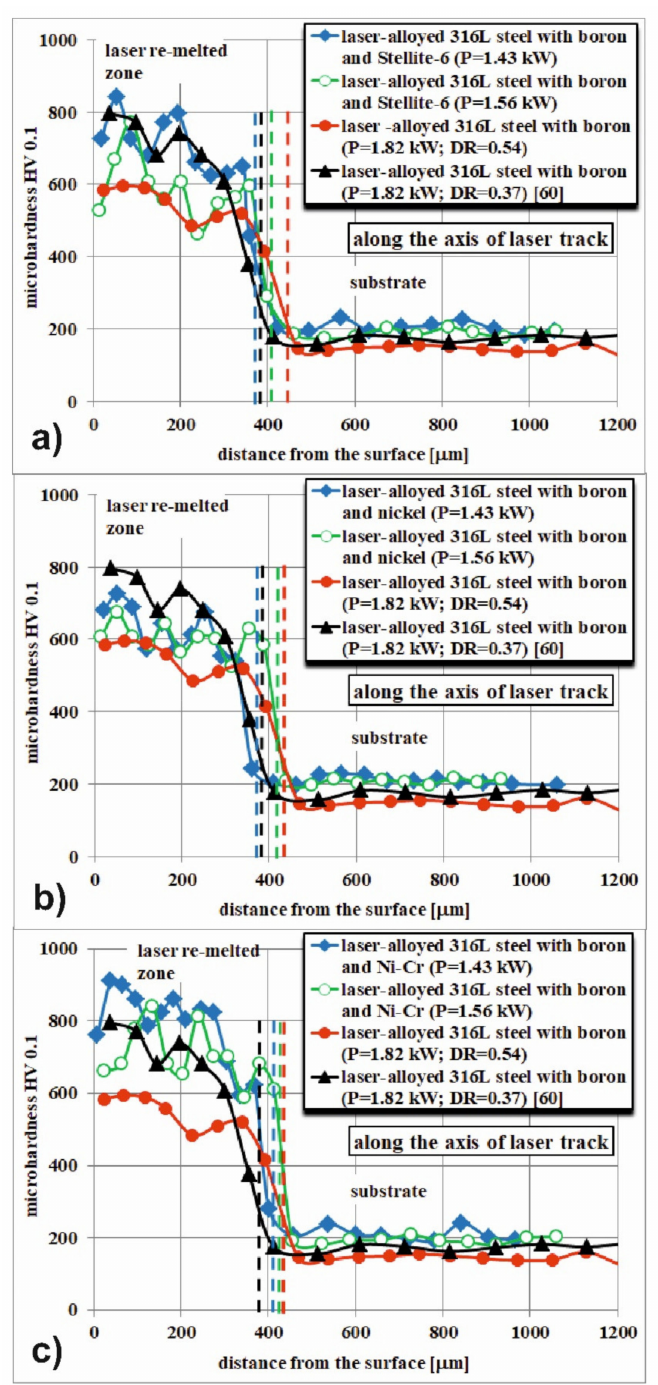
Figure 5. Microhardness profiles along the axes of selected multiple tracks after LSA with boron and Stellite-6 ( a ) with boron and nickel ( b ) and with boron, nickel and chromium ( c ) compared to the LSA with boron only, reported in the present study ( DR = 0.54) as well as in the paper [60] ( DR =